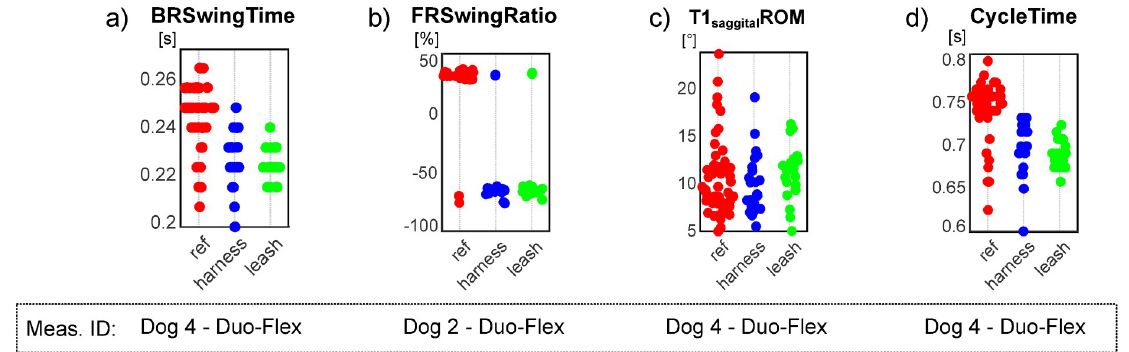
Fig 13. Anomalistic distributions. a) discreet values for swing time; b) negative swing ratio in case of Dog 2; c) distribution of T1 sagittal spine angle range of motion with a notable tails towards larger values; d) large tail towards lower values on the cycle time parameter of Dog 4 on the reference trial (red points).